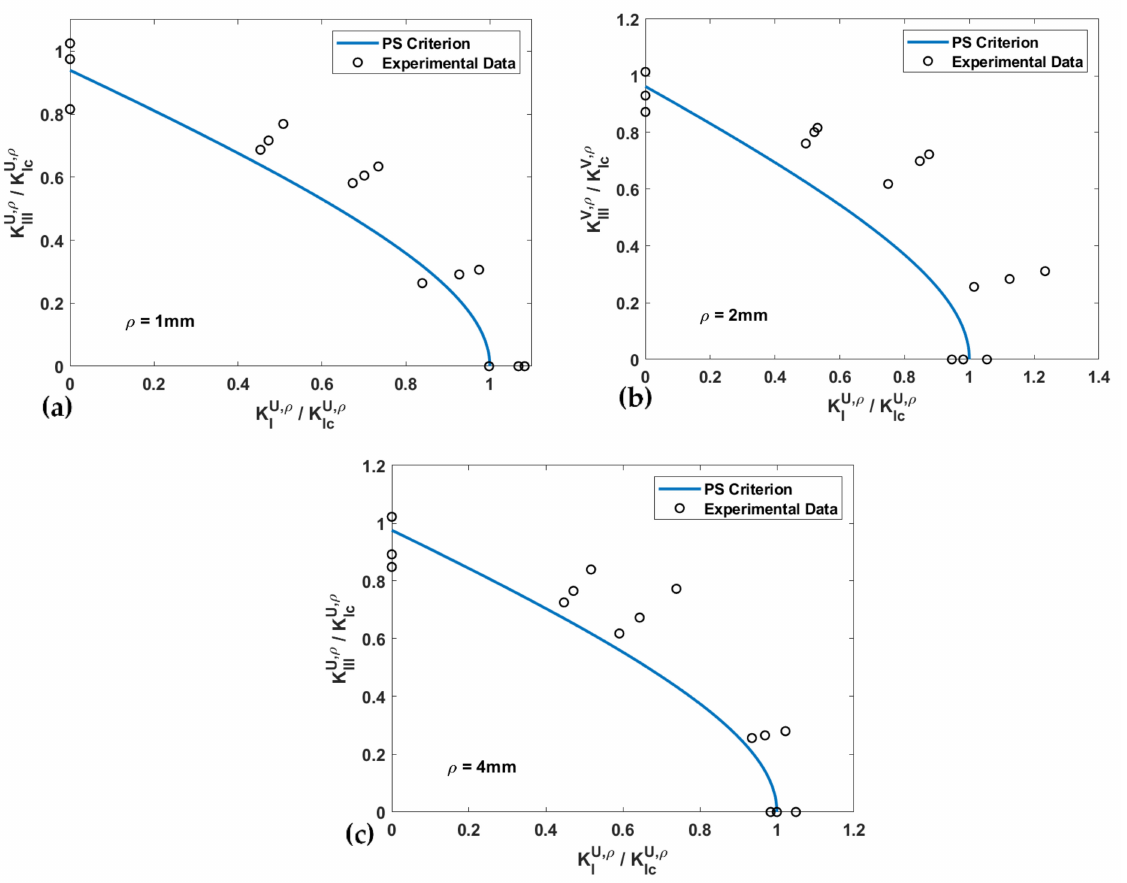
Figure 8. Fracture limit curves of the PS criterion and the experimental data of U-notched spruce wood specimens. ( a ) ρ = 1 mm; ( b ) ρ = 2 mm; ( c ) ρ = 4